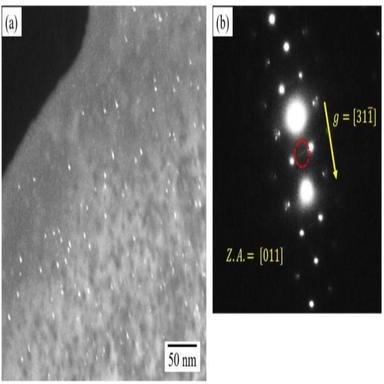
(a) Rel-rod dark field TEM image showing Frank loops in ThO2 after proton irradiation, (b) diffraction pattern showing streak at g = 1/2 (see red circle) obtained at zone.